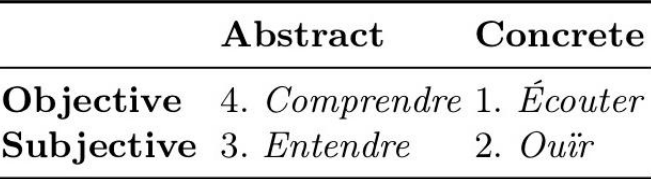
Figure A1. Schaeffer’s quatre écoutes, his four modes, or ways, of listening (1967).